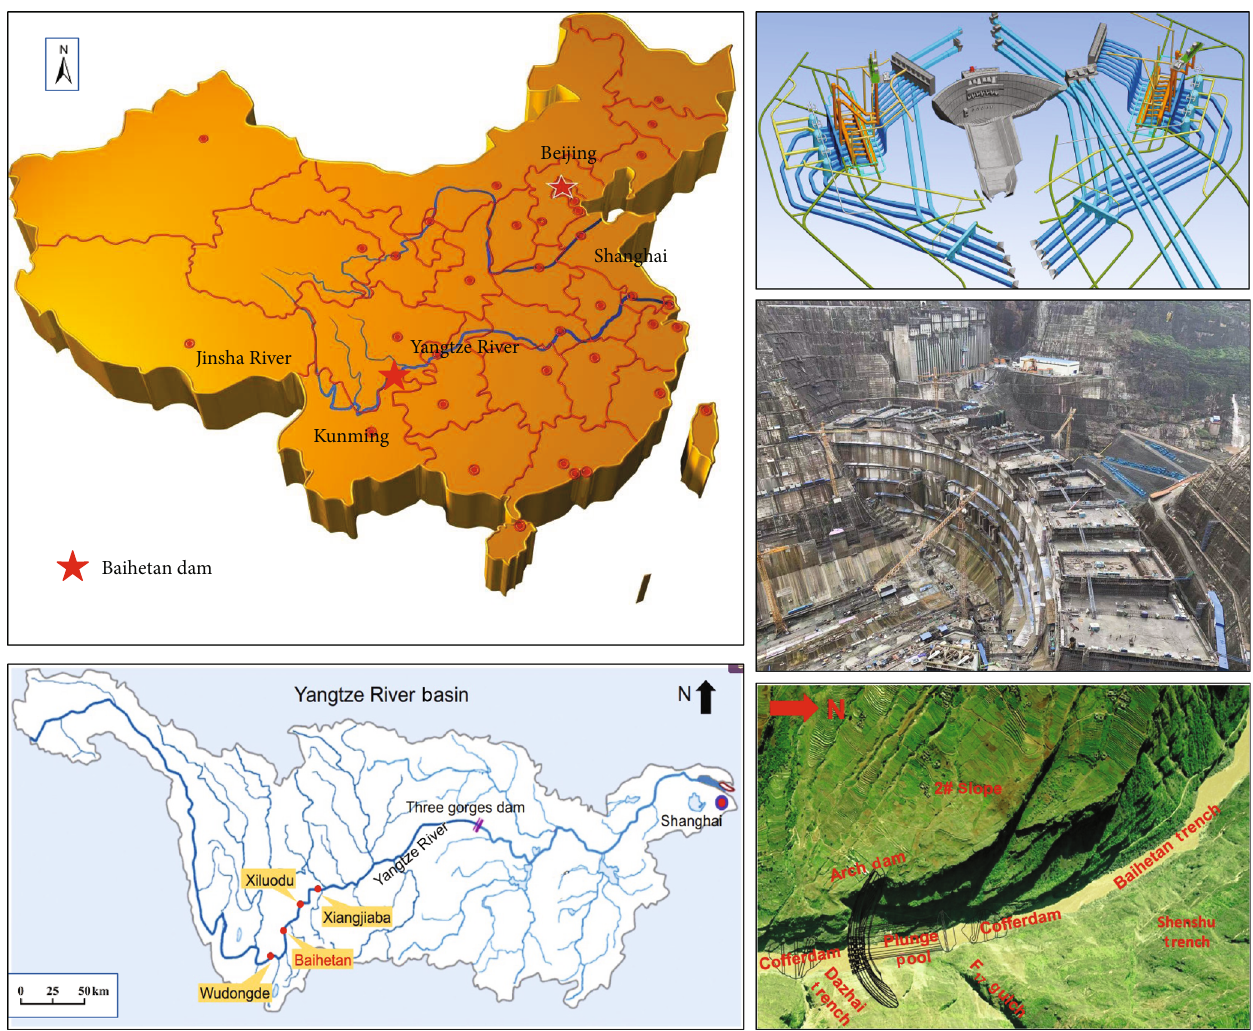
Figure 2: Baihetan hydropower station located in China